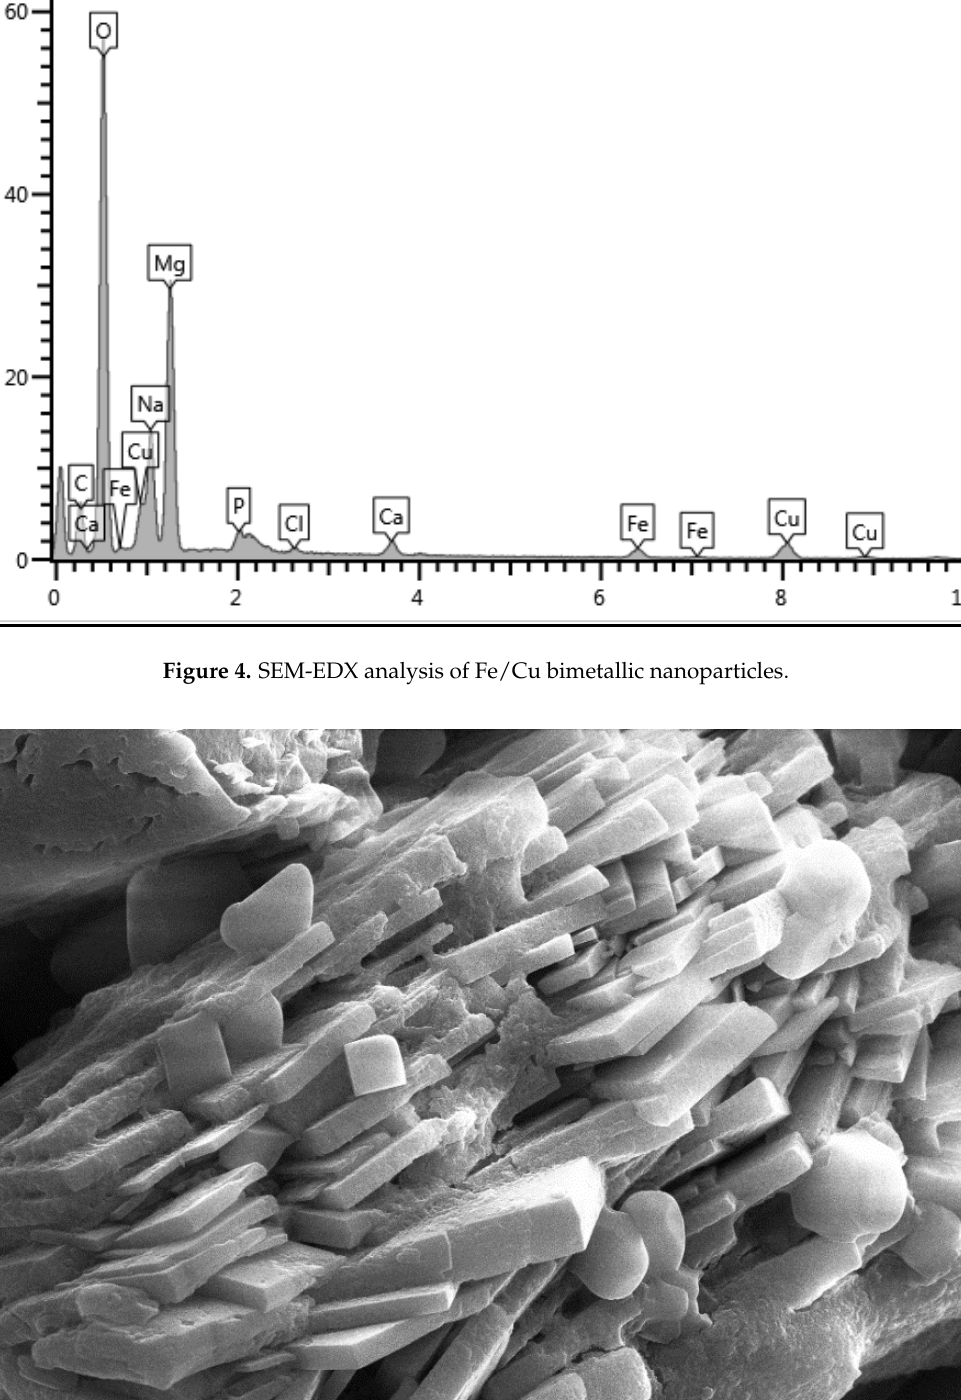
Wavelength (nm) Figure 6. UV – vis analysis of Fe/Cu bimetallic nanoparticles. 3.4. TEM Analysis of Fe/Cu Bimetallic Nanoparticles Figure 7 represents the TEM image of Fe/Cu bimetallic nanoparticles.